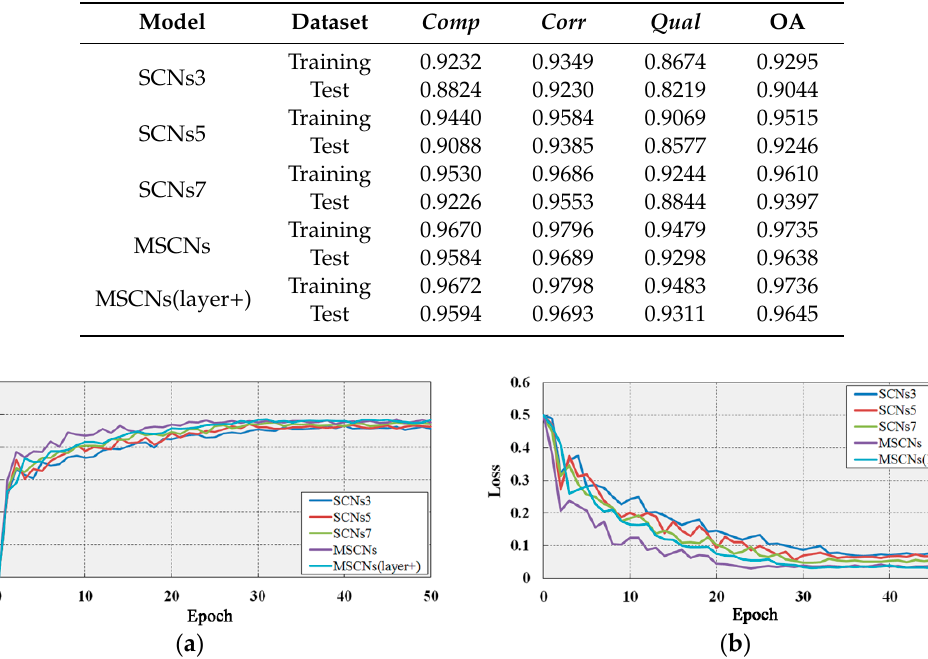
Table 2. Metrics of MSCNs, including Comp , Corr , Qual , and OA .